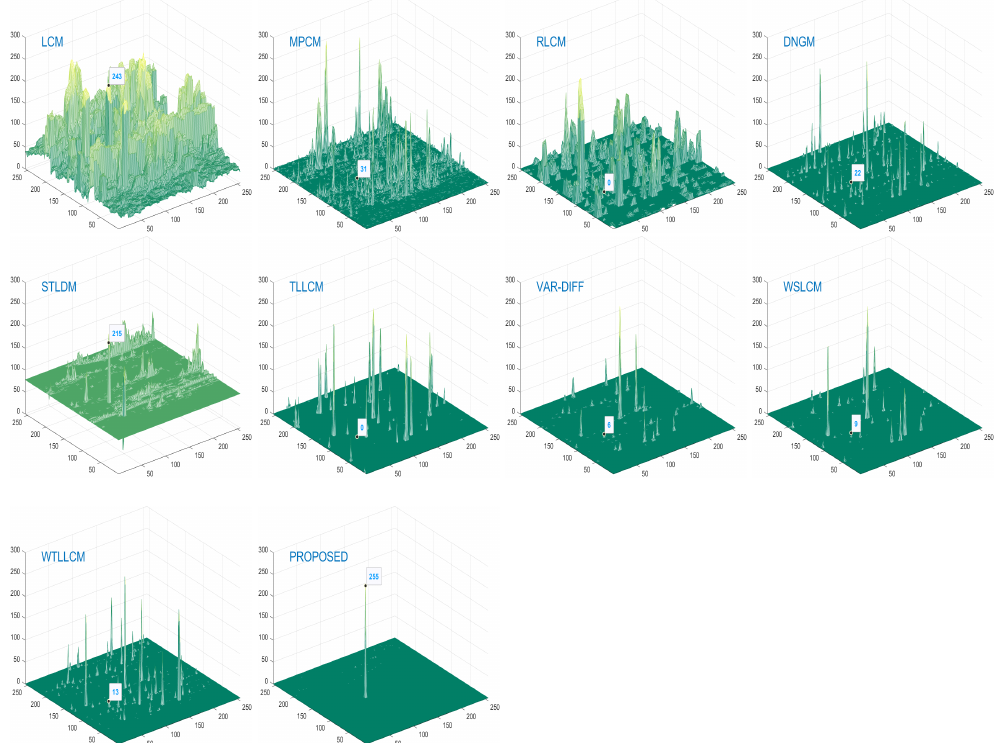
Figure 16. Three-dimensional displays of detection results on one frame in data1. Different subgraphs are the results of different